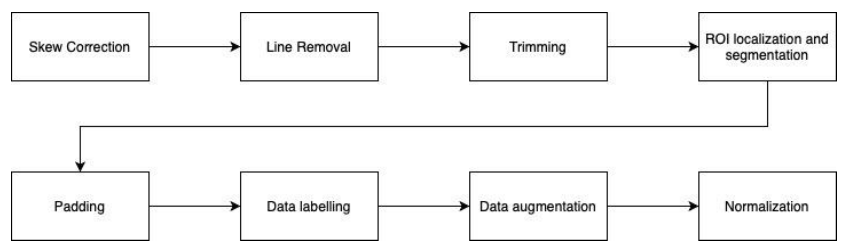
Figure 4. The flow of pre-processing approach.